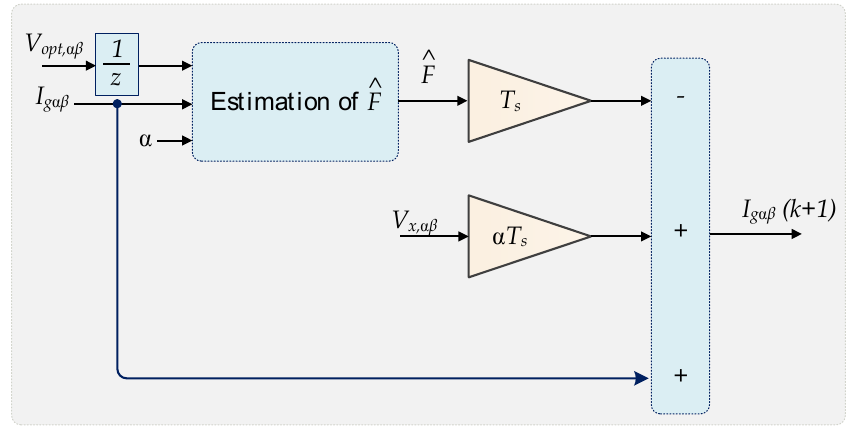
Figure 6. Con fi guration of the MFPC for the grid current control. Figure 6. Configuration of the MFPC for the grid current control. A complete flowchart of the proposed MFPC for the three-phase NPC is depicted in Figure 7. The MFPC first considers the necessary measurements to predict the desired control objectives. To improve accuracy, these measurements are filtered from the noise. Next, the best switching state is selected according to the minimum cost function.